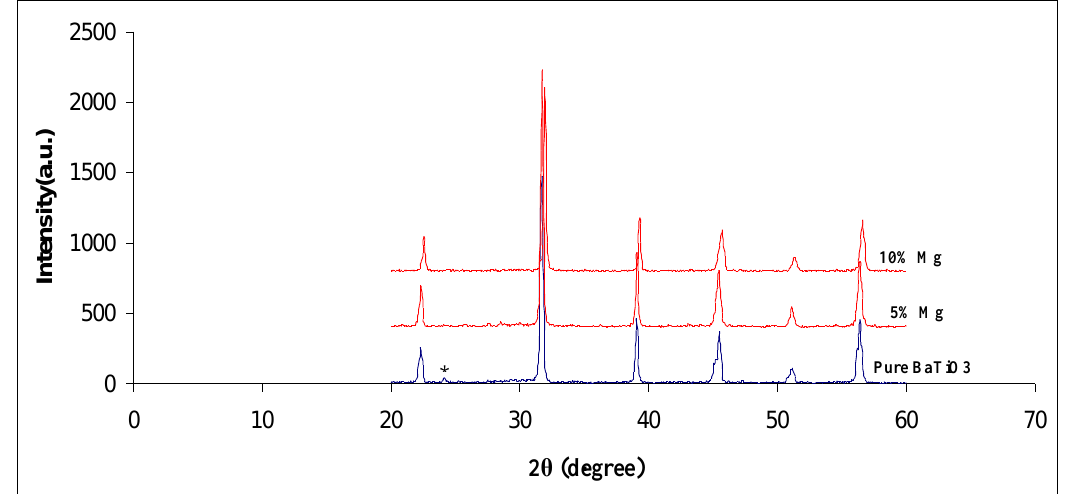
Fig. 8: XRD for BaTiO